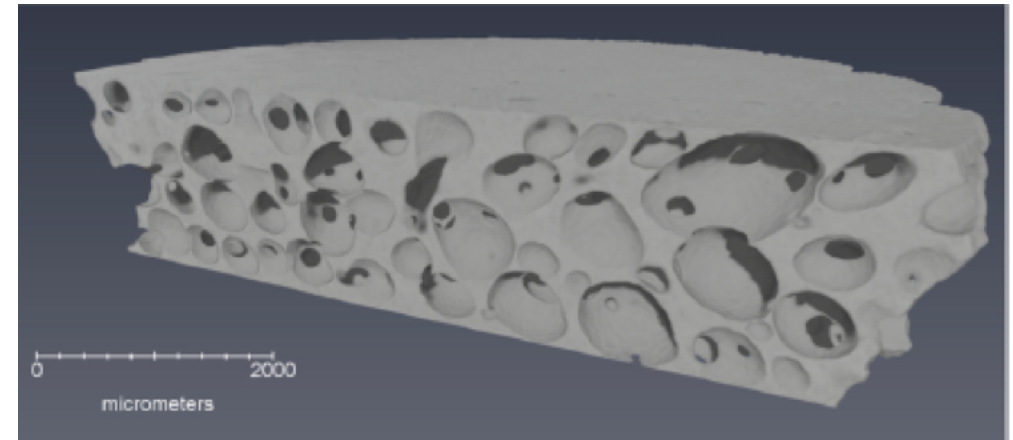
Figure 6. X-ray computed tomograph of SX358 foam illustrating the open cell, stochastic pore structure. Pore diameters range from 10 s of µ m to mm in diameter. (image credit: Brian Patterson, Los Alamos National